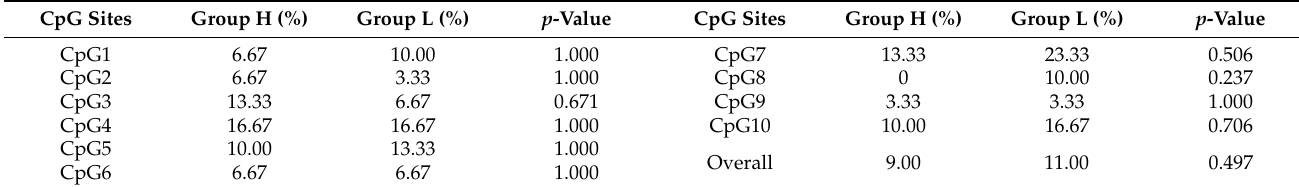
Table 4. Methylation levels of CpG II sites in the high and low yield groups.